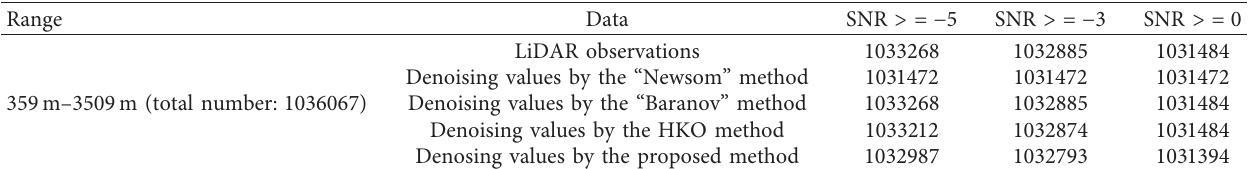
Figure 9: (a) The LiDAR data and (b) SNR values collected on 4 March 2015 from 00:00 :16 to 00 :00: 39. The denoising results by (c) “DWT” method, (d) “EMD-CIIT” method, (e) “Newsom” method, (f) “Baranov” method, (g) HKO method, and (h) the proposed scheme (denoted by TV). Table 1: The comparison of noisy observations removal by the “Newsom” method, “Baranov” method, HKO method, and proposed